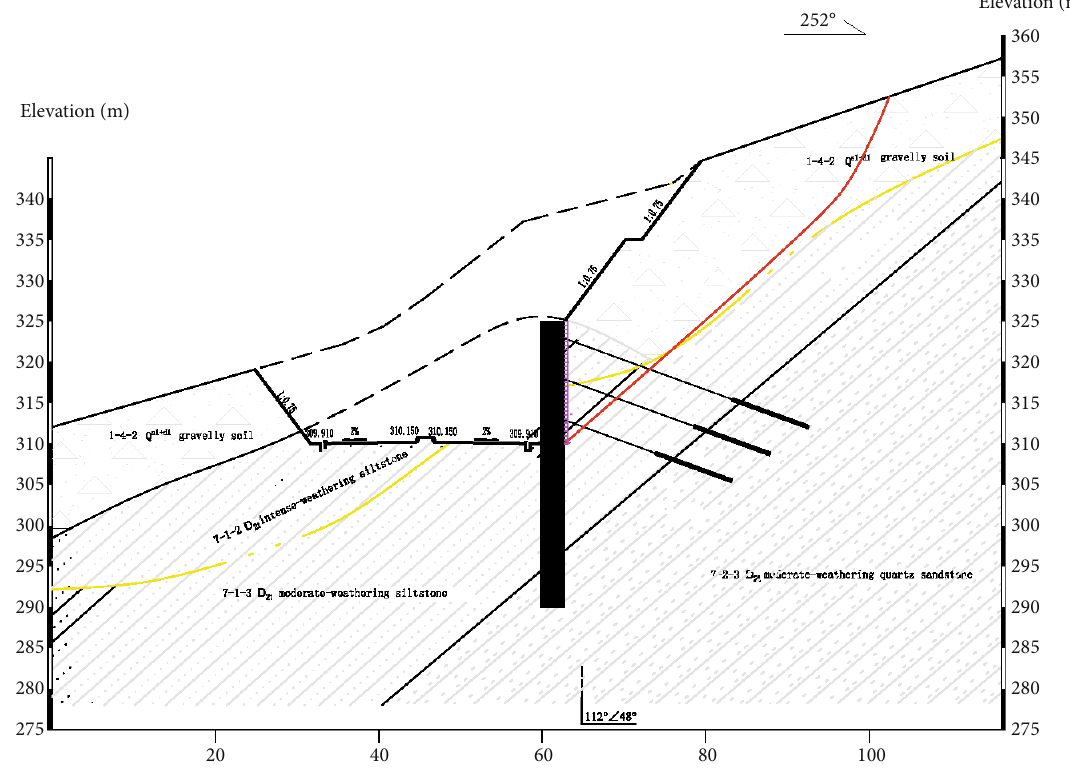
Figure 3: Engineering geology cross-section pro fi le with reinforcement work of the cut slope (A-A ’ ).